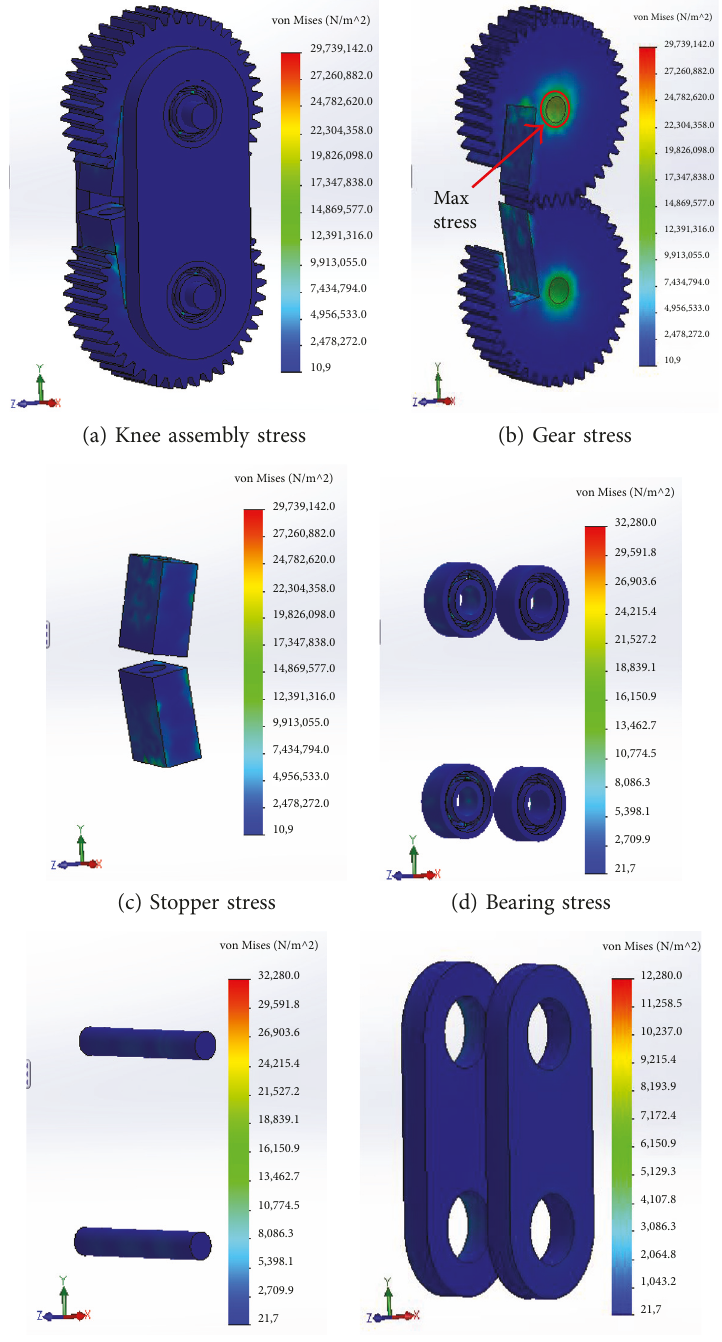
Figure 8: von Mises stress of the knee joint